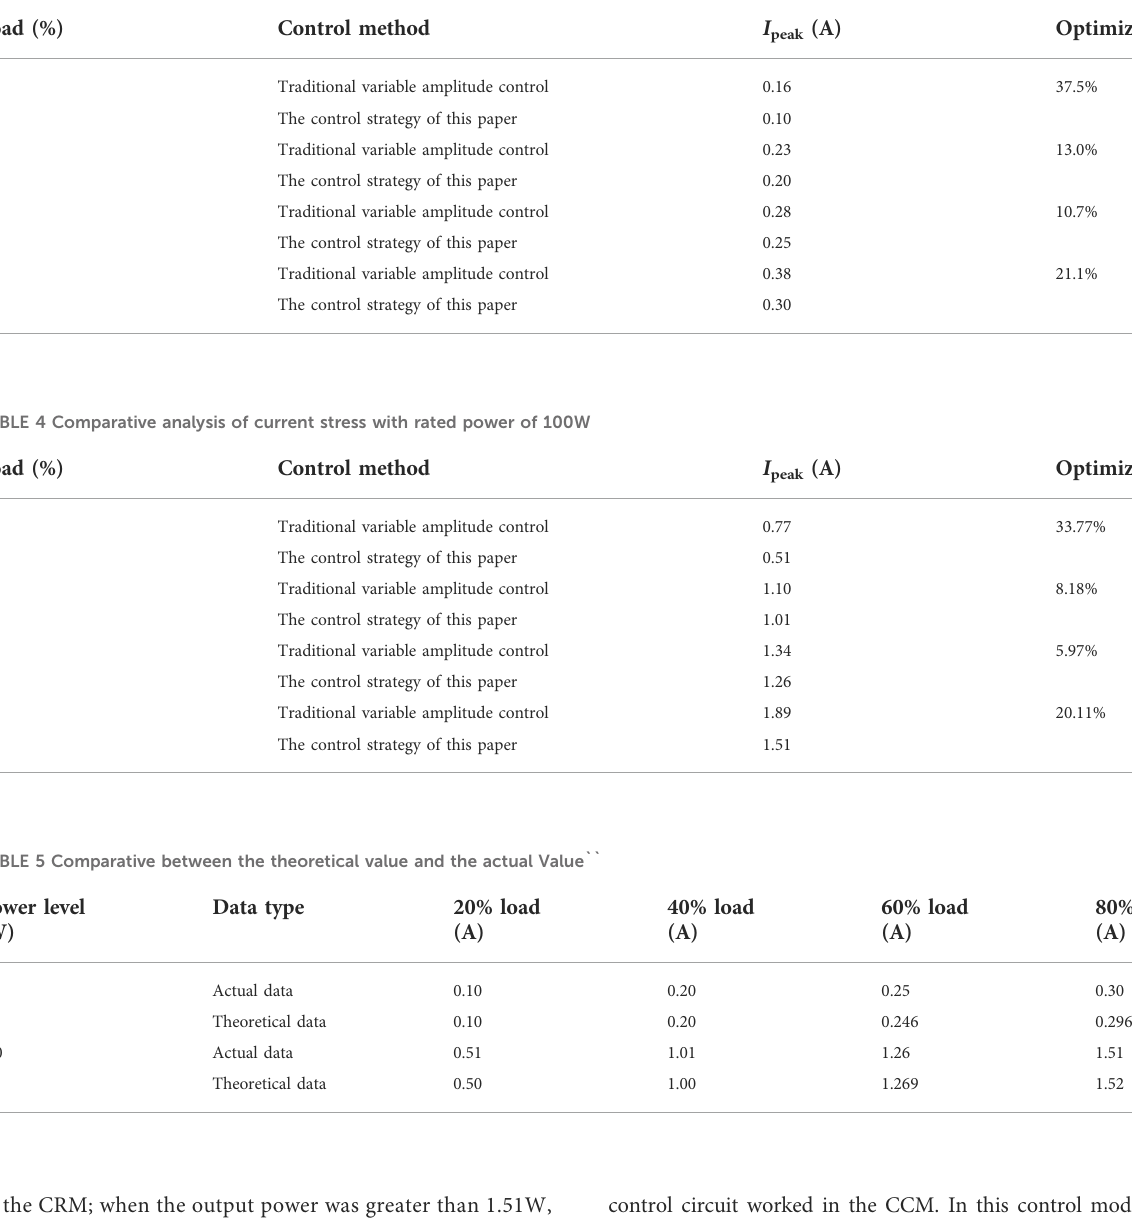
TABLE 3 Comparative analysis of current stress with rated power of 3W